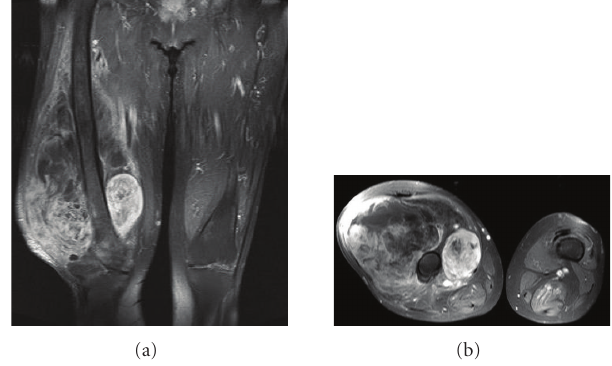
Figure 3: (a) A coronar magnetic resonance imaging (T2-weighted) showing the tumor infiltration of the knee. (b) An axial T2- weighted sequence showing the tumor extension of the whole quadriceps muscles.